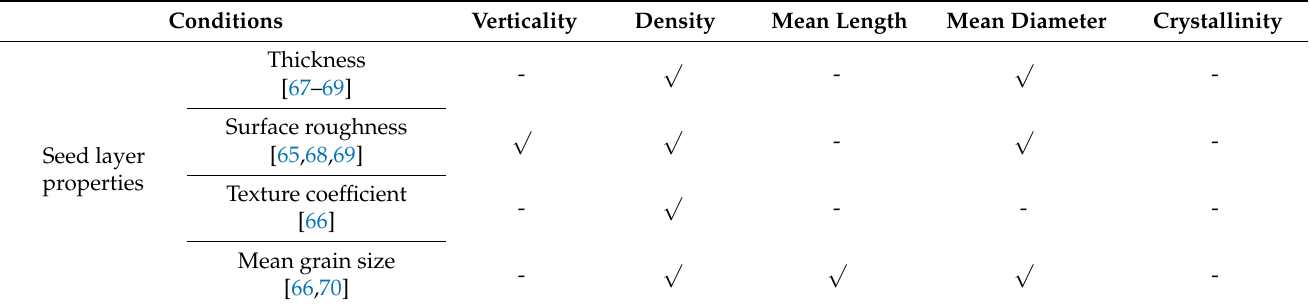
Figure 3. ( A ) Schematics of ZnO NW growth depending on substrate surface conditions and seed layer: ( a ) Without the ultraviolet ozone (UVO) treatment under a lower annealing temperature (T annealing ); ( b ) with UVO treatment; ( c ), ( d ) with varied T annealing conditions [67]; ( B ) schematic representation of the NWs; growth [68]. Table 1. Factors influencing the morphology of hydrothermally grown NWs.